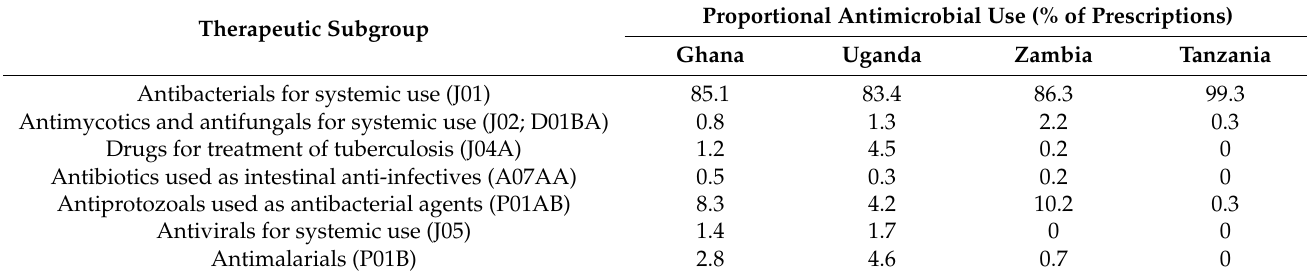
Table 3. Proportional antimicrobial use by country grouped by therapeutic subgroup. Proportional Antimicrobial Use (% of Prescriptions) Therapeutic Subgroup Ghana Uganda Zambia